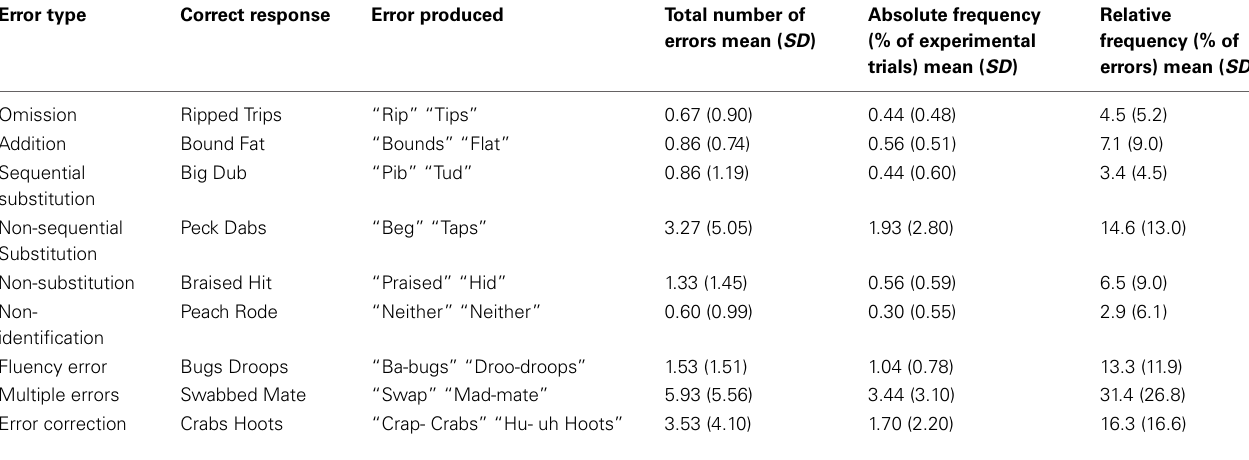
Table 1 | Error types with absolute and relative frequencies in experimental